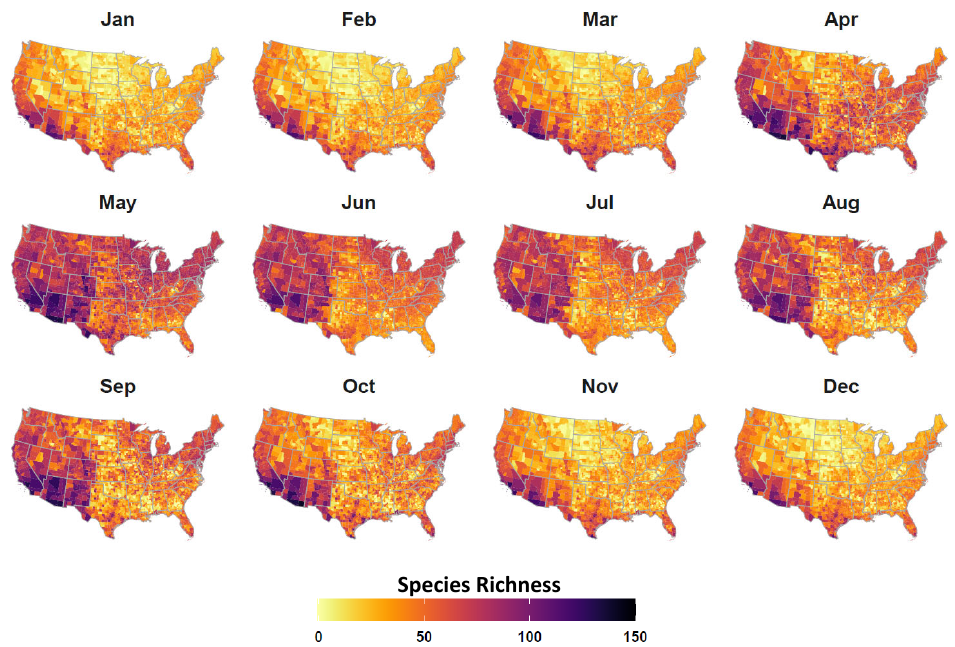
Figure A4. Dynamic avian host species richness. Species richness covariate under assumption of a dynamic species pool (monthly varying). Maps are color coded according to legend at bottom with darker tones indicating higher species richness.